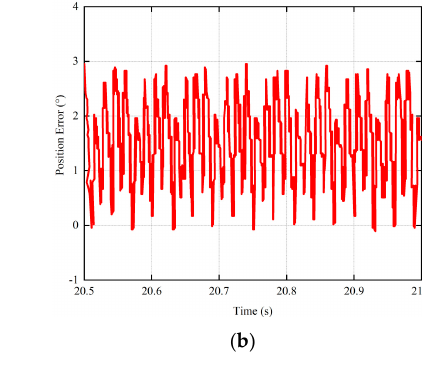
= 1.5 λ λ = . ( a ) Figure 13. Current response comparison based on flux linkage changed in controller λ (cid:48) f . f f